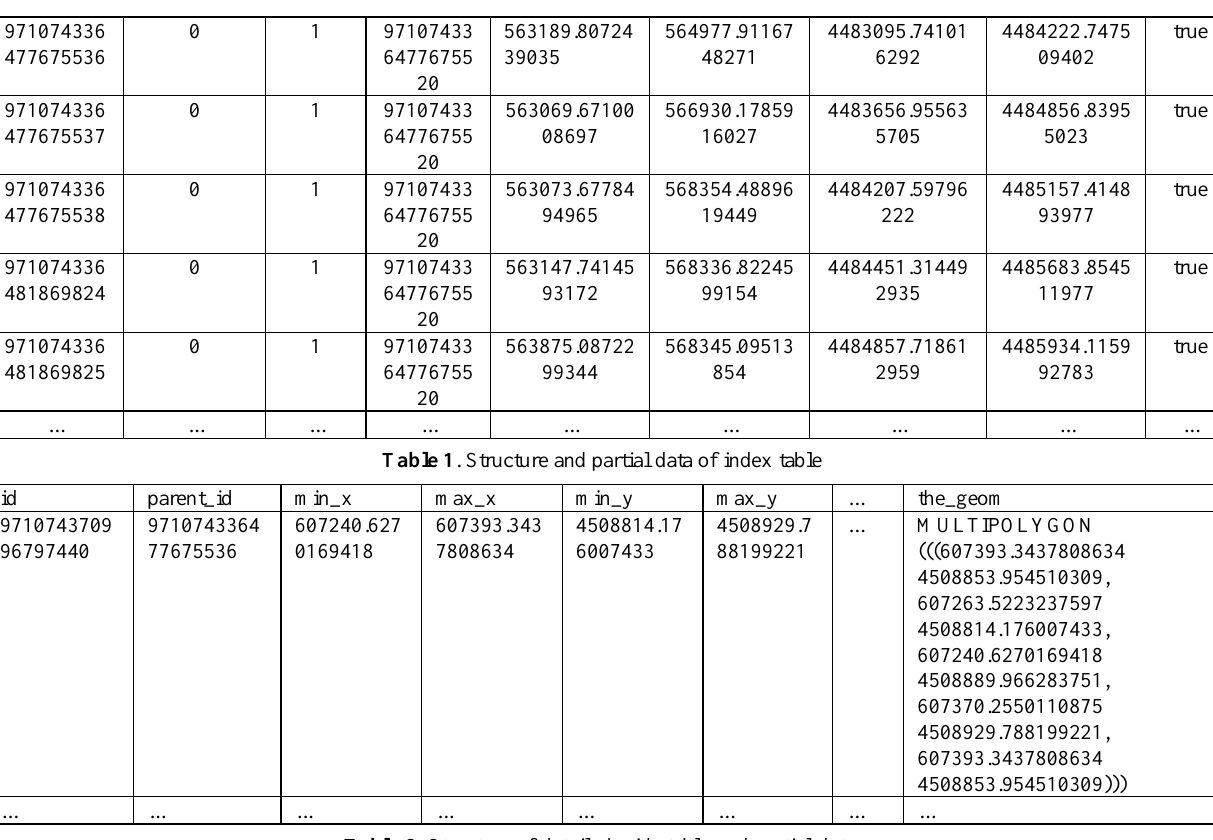
Table 2 . Structure of detailed wide table and partial data.